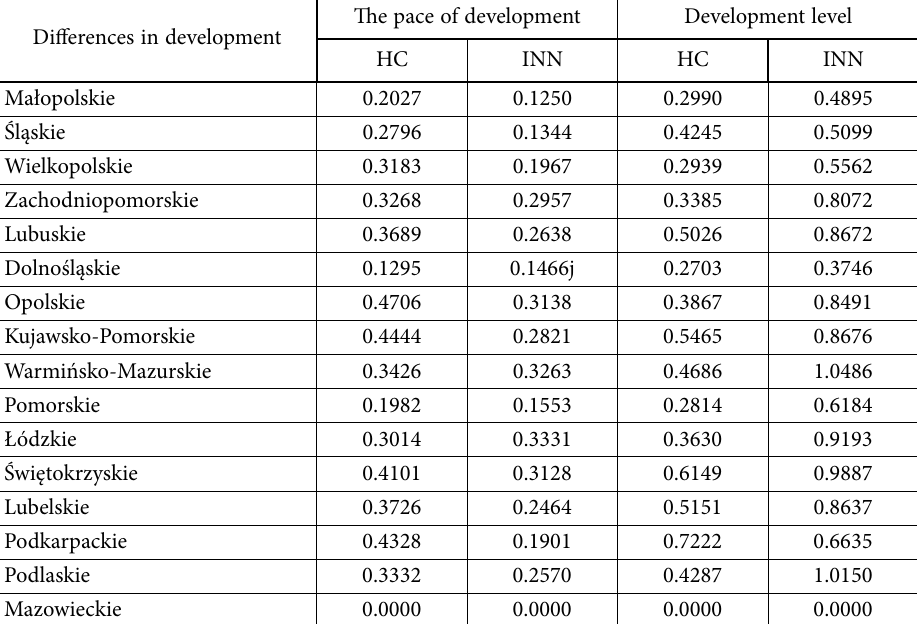
Table 1. Differences in the development of Polish regions in the field of the rate and level of human capital (HC) development and innovation (INN) in the years 2004–2018 in the Mazowieckie voivode- ship (source: own elaboration. Calculations were performed using the R program) The pace of development Development level Differences in development HC INN HC INN